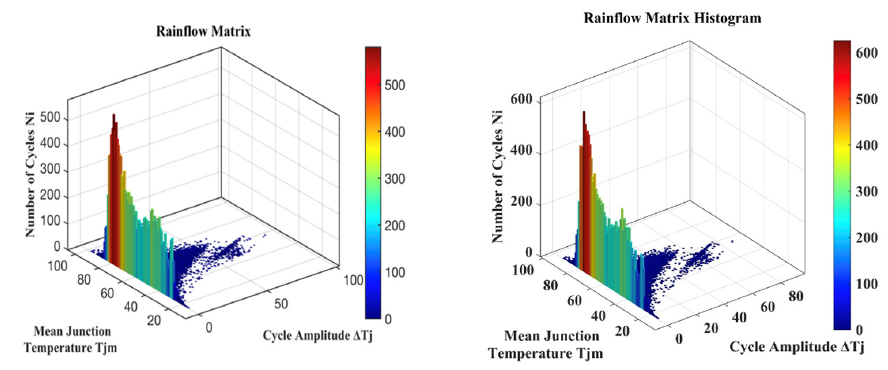
Figure 7. RF Matrix in India.